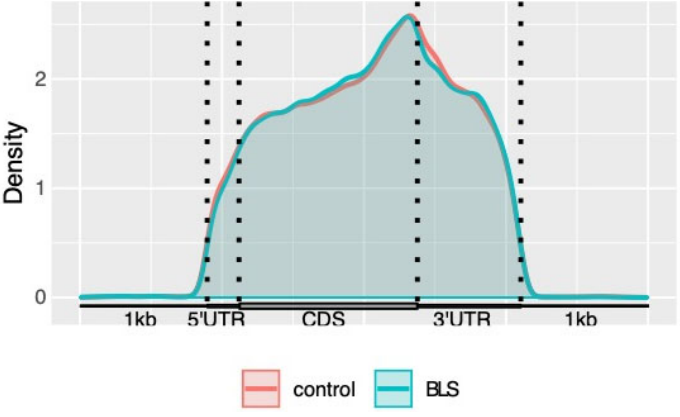
Figure 3. Density of m6A methylation peaks in mRNA transcripts.